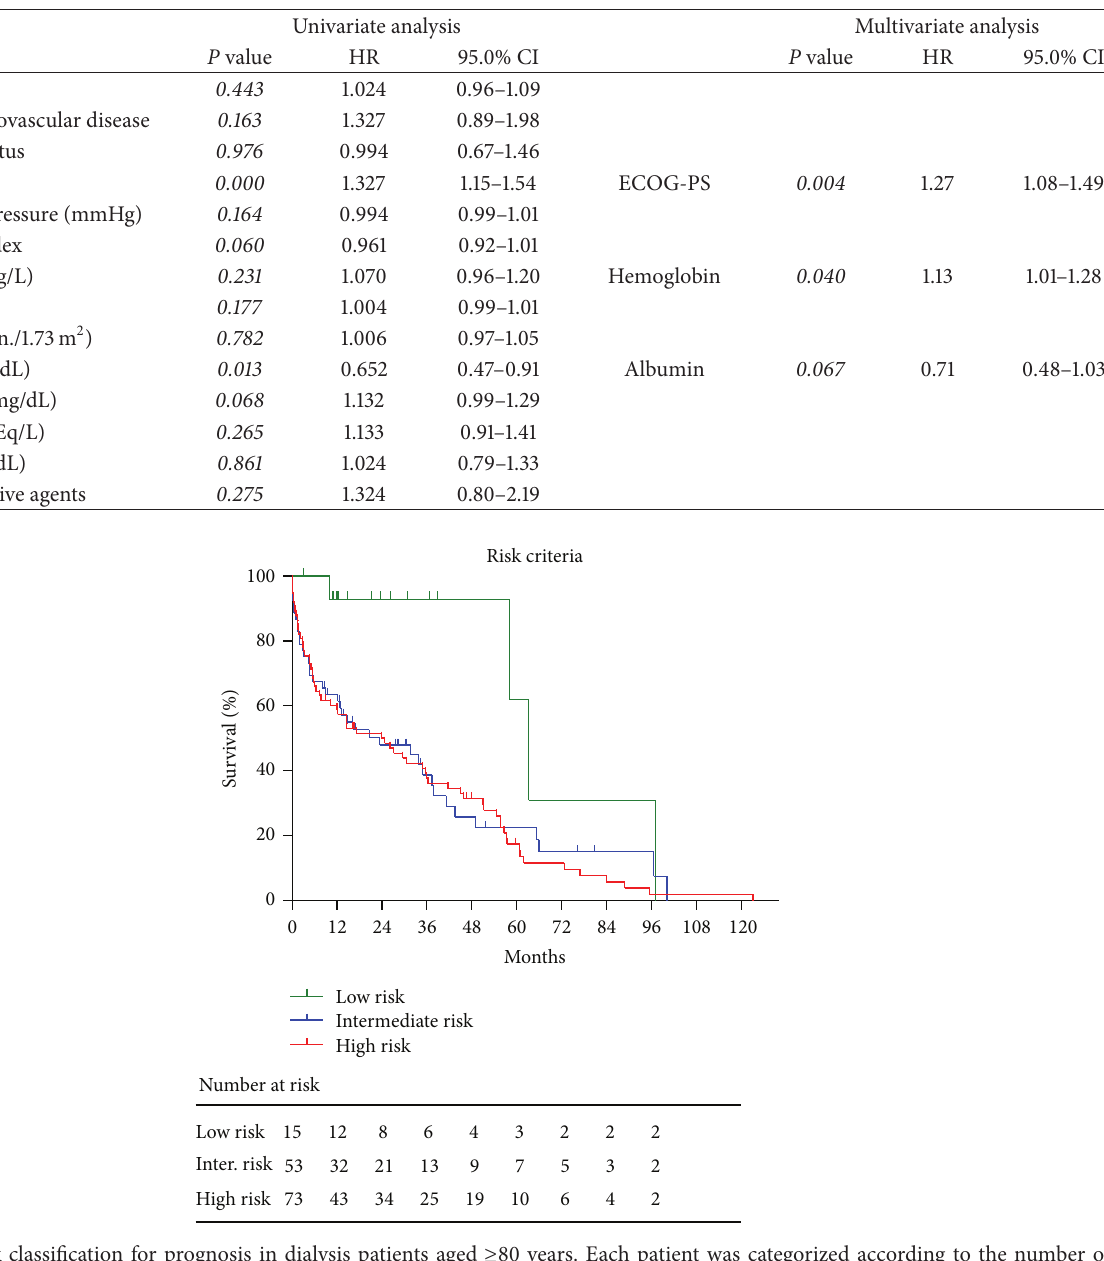
Figure 5: Risk classification for prognosis in dialysis patients aged ≥ 80 years. Each patient was categorized according to the number of selected risk factors using Cox regression multivariate analysis to evaluate the predictive potential of risk criteria for prognosis. Each existing risk factor was scored as 1, and scores for all the other risk factors were summated. Patients were classified into three groups according to the number of risk factors: the low-risk group (patients with no risk factor), the intermediate-risk group (1 risk factors), and the high-risk group (2 risk